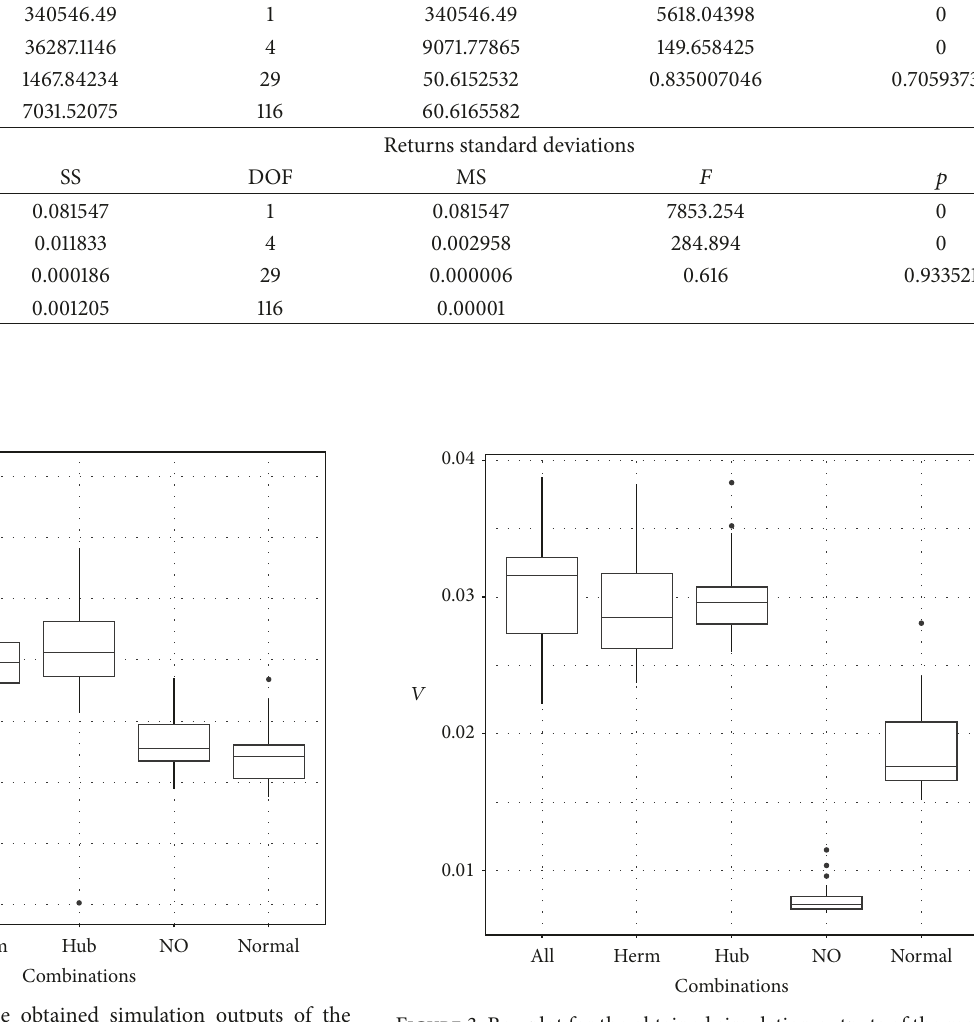
Figure 3: Box plot for the obtained simulation outputs of the mean returns standard